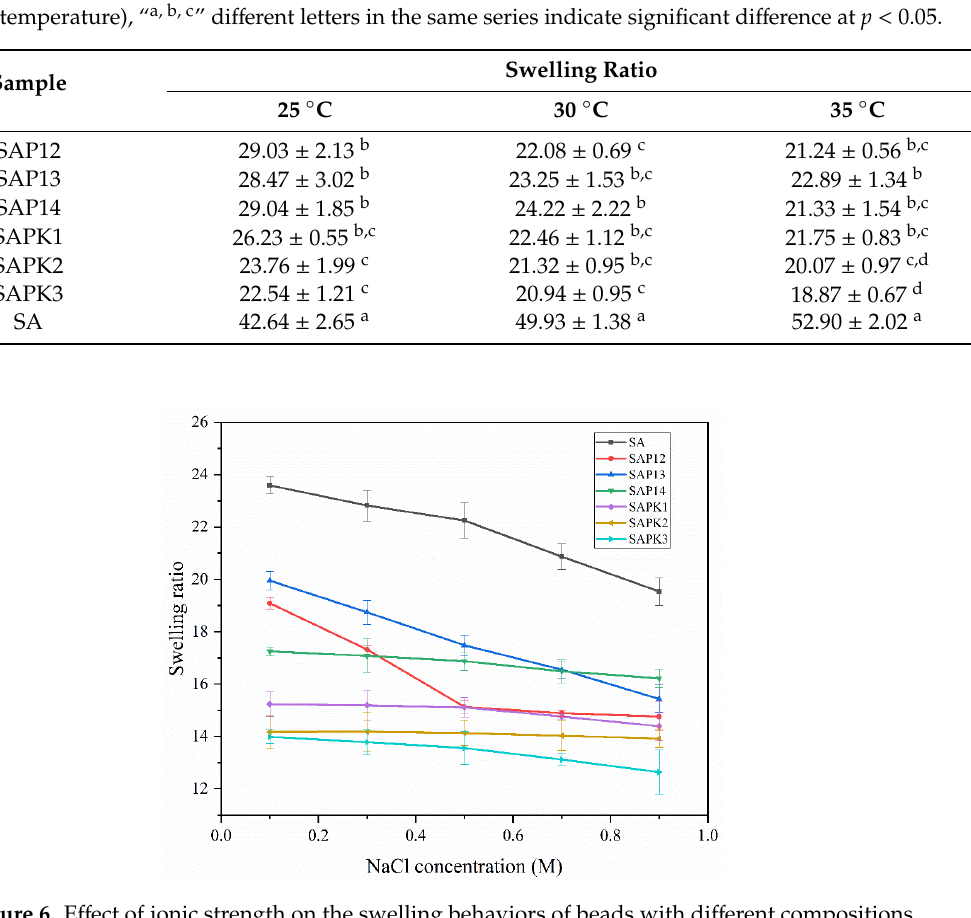
Figure 6. E ff ect of ionic strength on the swelling behaviors of beads with di ff erent Figure 6. Effect of ionic strength on the swelling behaviors of beads with different compositions.